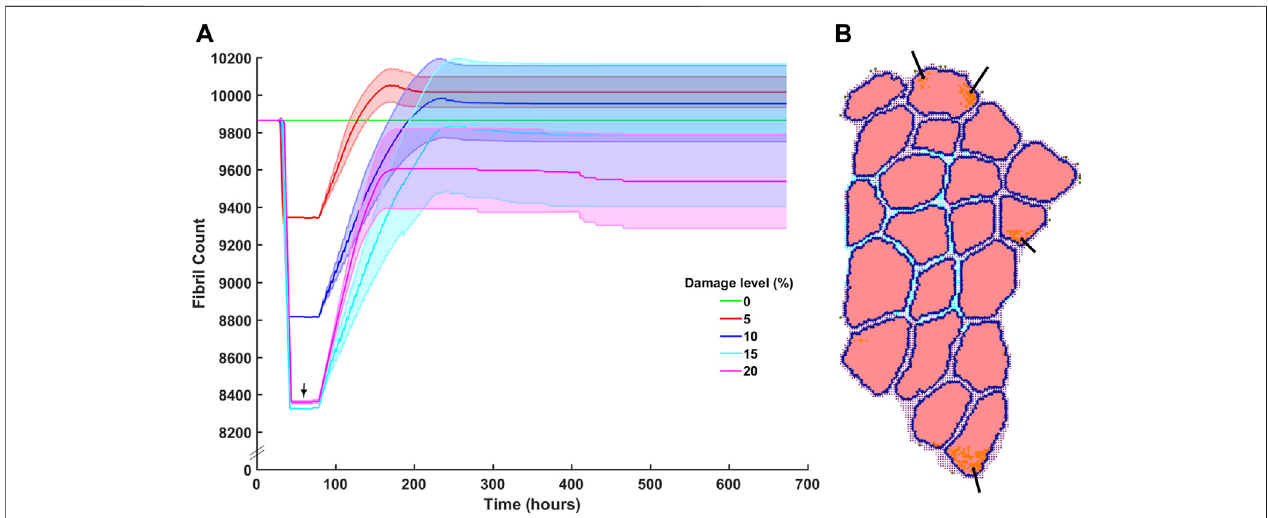
FIGURE 6 | Fibril recovery post injury at varied damage levels of 0% fi brils to 20% with 5% steps. (A) Fibril recovery at 5 and 10% showed average end fi bril count increase. At 15% clearance of damaged cells was effective and repair was close to recovery, however, at 20% damage, the clearance of damaged fi brils did not reach 20% (arrow) and therefore (B) in fl ammatory cells and damaged fi brils remain within the fi bers.